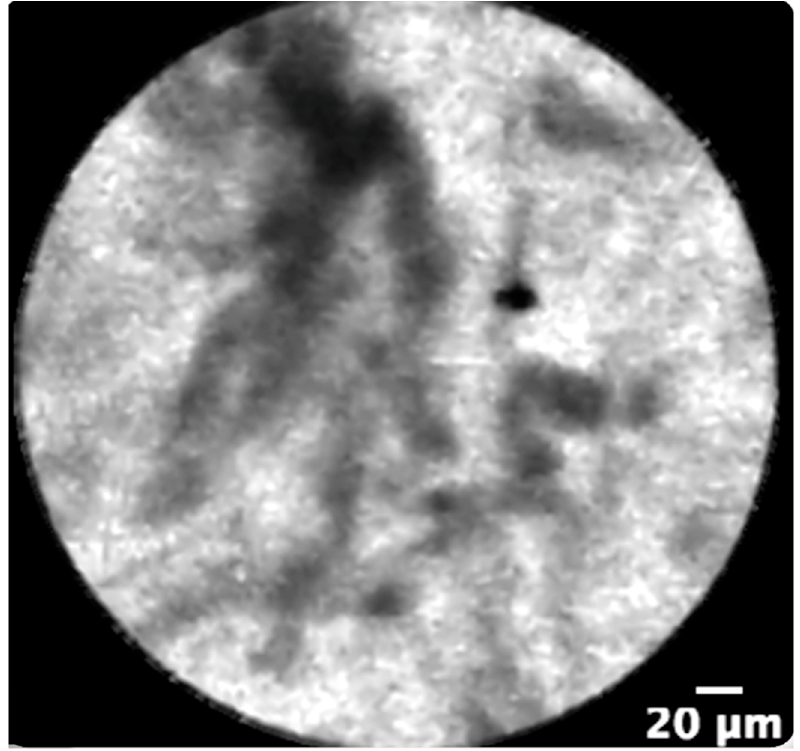
Figure 2. Confocal laser endomicroscopy showing a thickened reticular structure representing a criterion for malignancy.